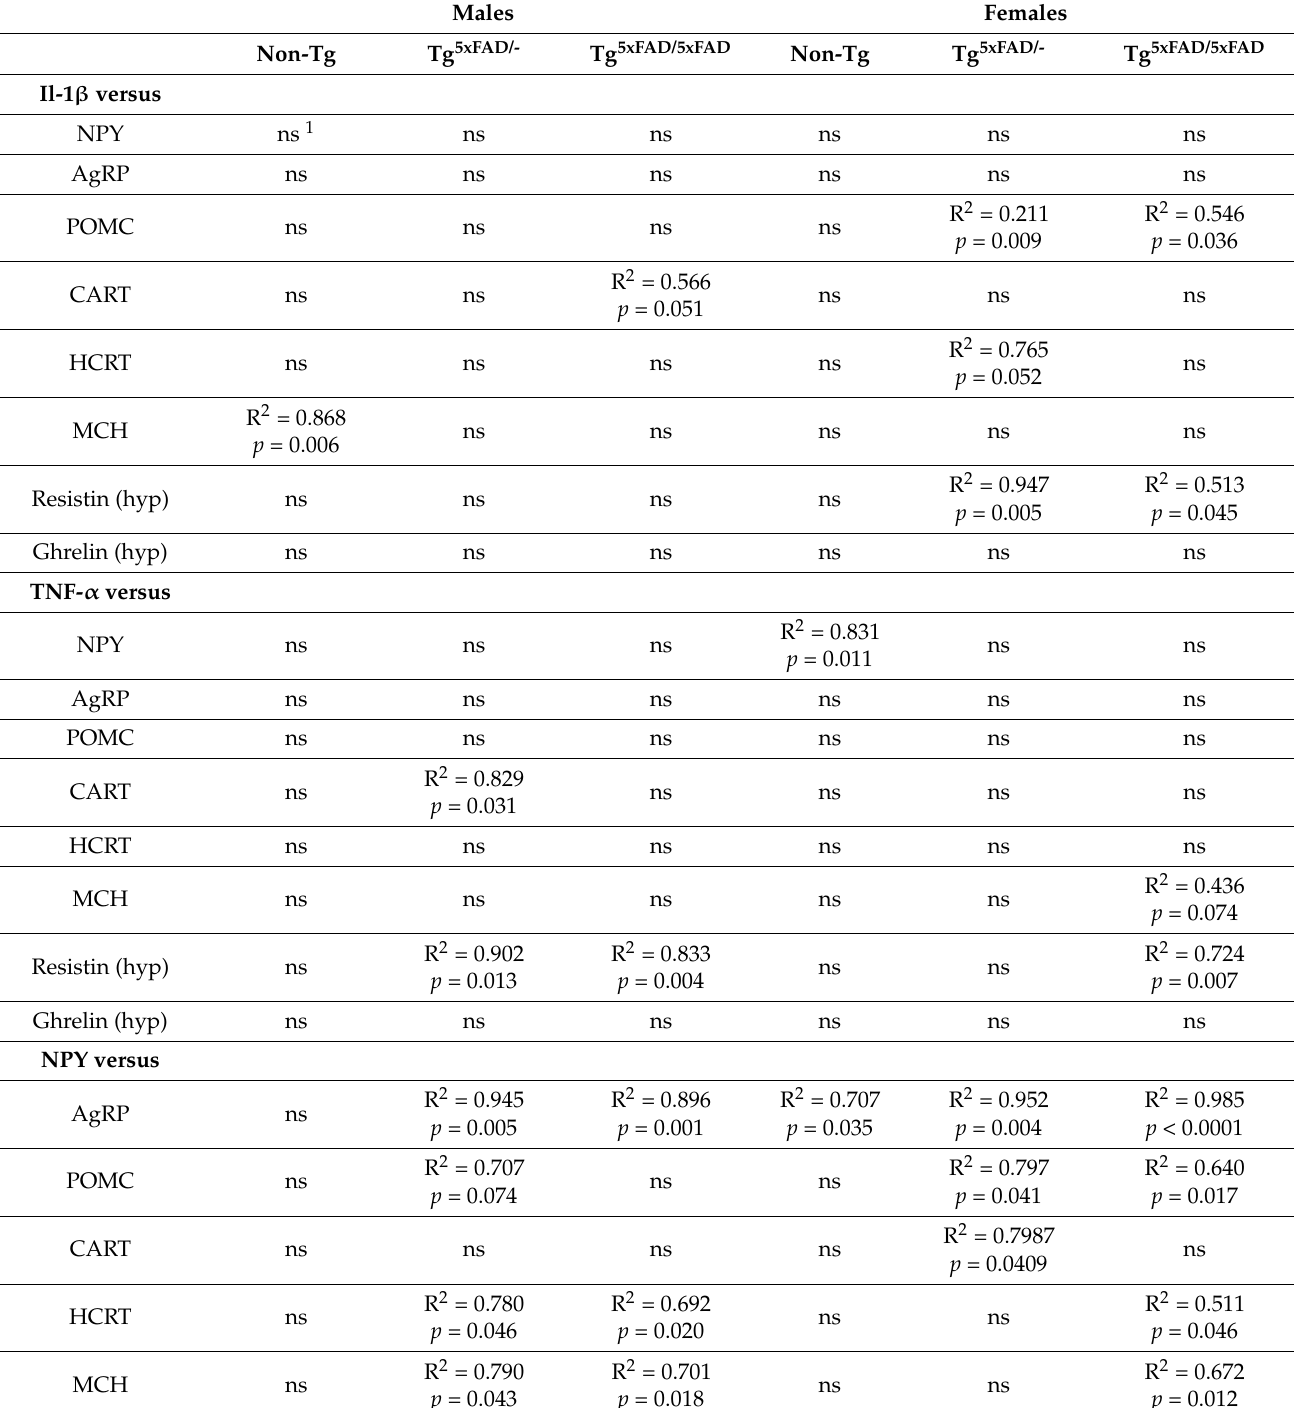
Table 4. Correlations between food intake-regulating hypothalamic neuropeptides and inflammatory markers IL-1 β and TNF- α , as well as NPY in 5xFAD mice at 6 months of